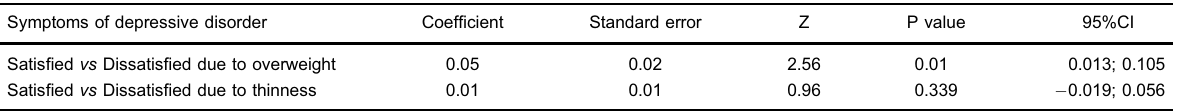
Table 2. Effect of dissatisfaction with body image on depressive disorders in the evaluated adolescents, weighted by the inverse probability of selection. Symptoms of depressive